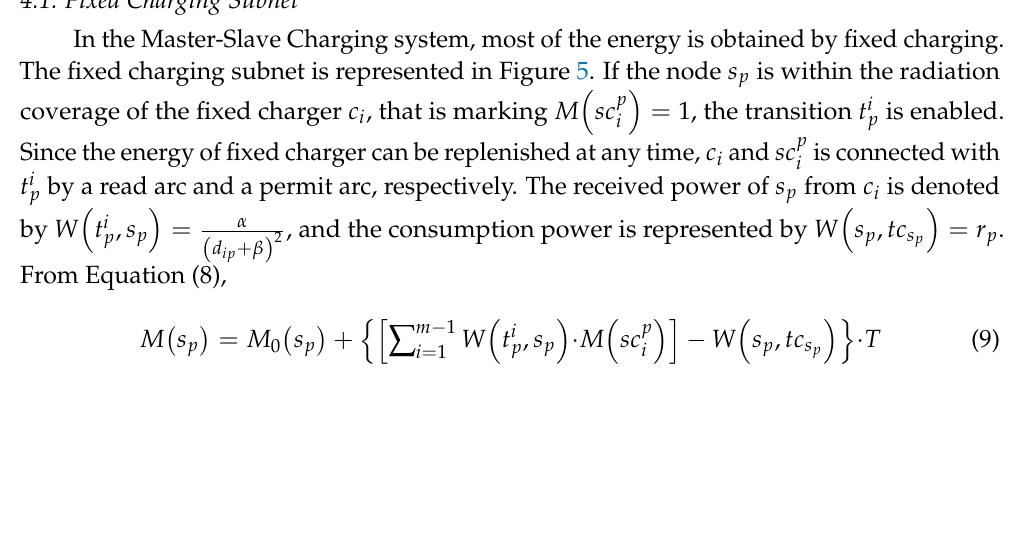
Table 3. Interpretation of place and transition for mobile charging subnet.